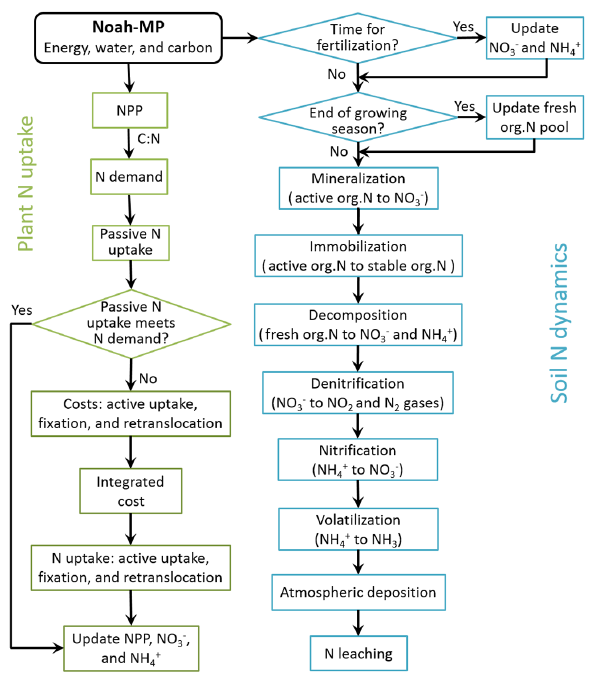
Figure 1. Flow chart of the nitrogen dynamic model. org.N: organic